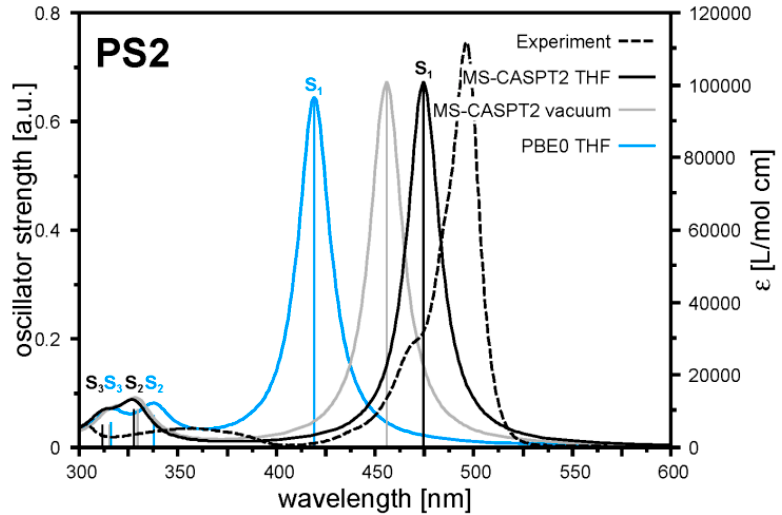
Figure 3. Experimental (black dashed line) and calculated UV–VIS absorption spectrum of 2 at MS-CASPT2 (solvent corrected: solid black, gas phase: solid grey) and PBE0 levels of theory (solvent-corrected: solid blue).